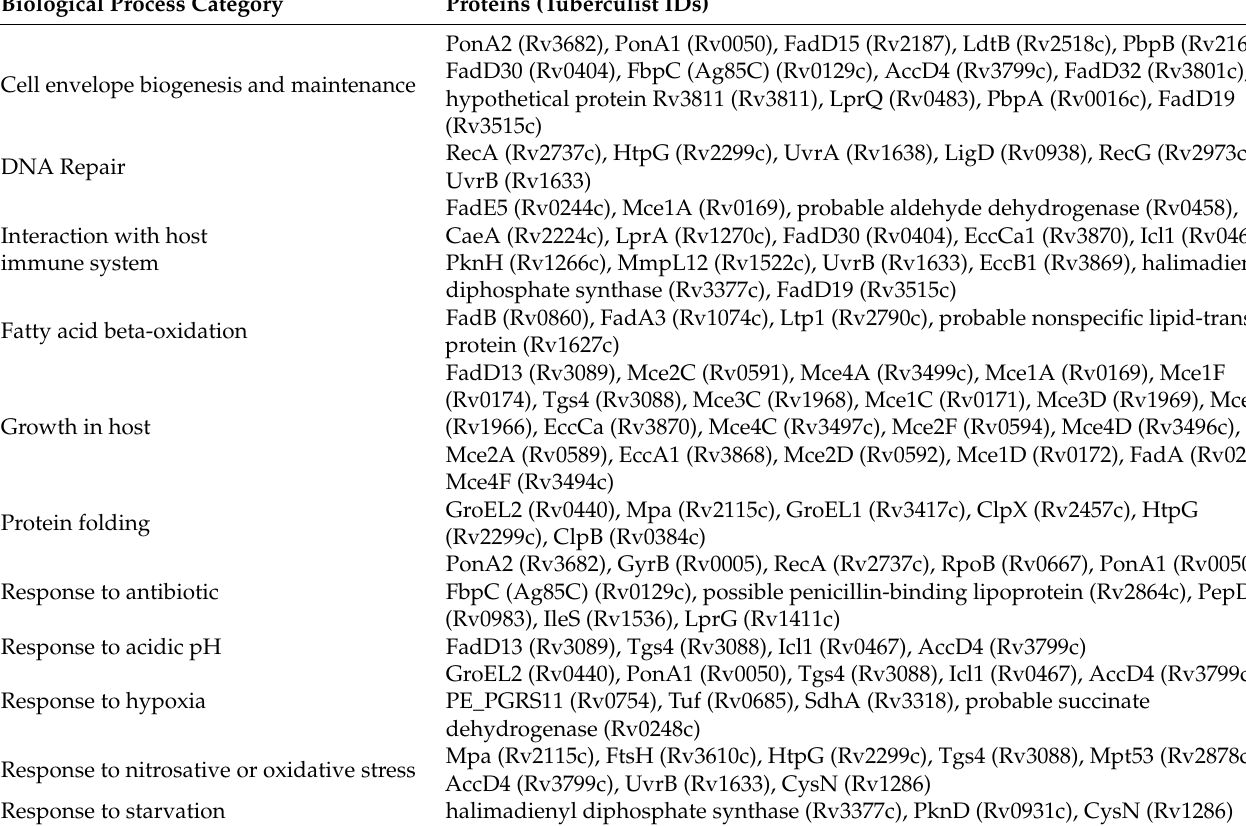
Table 2. Novel Vaxign-ML-predicted PAgs having biological processes related to MTB virulence or latency. More than 72 proteins are listed here due to redundancy between categories.